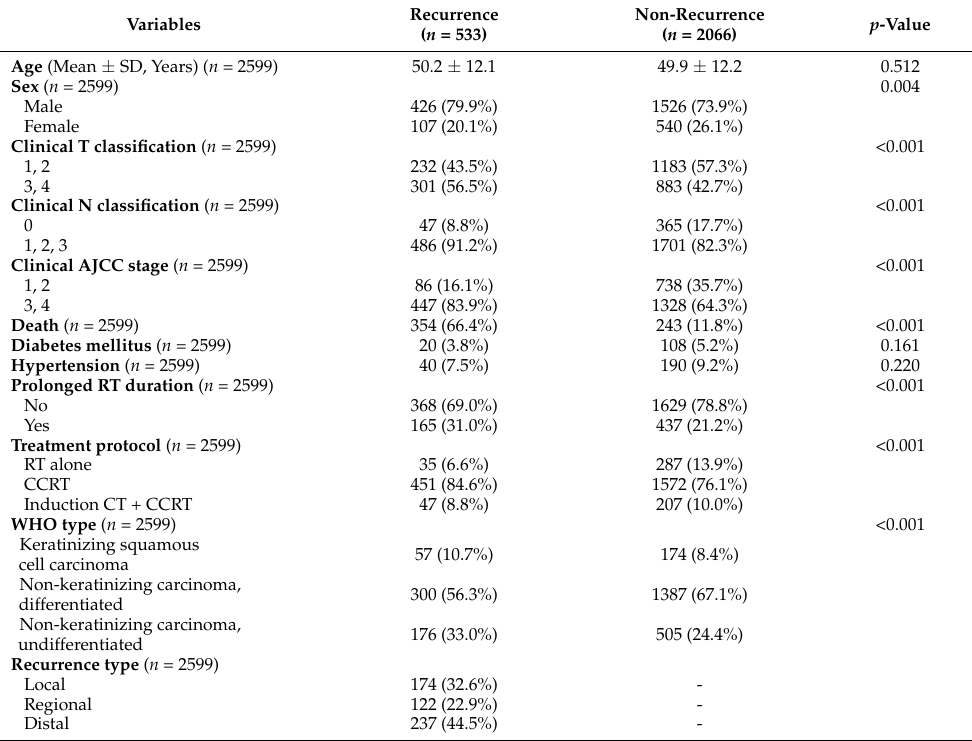
Table 1. Demographic data (recurrence vs. non-recurrence).